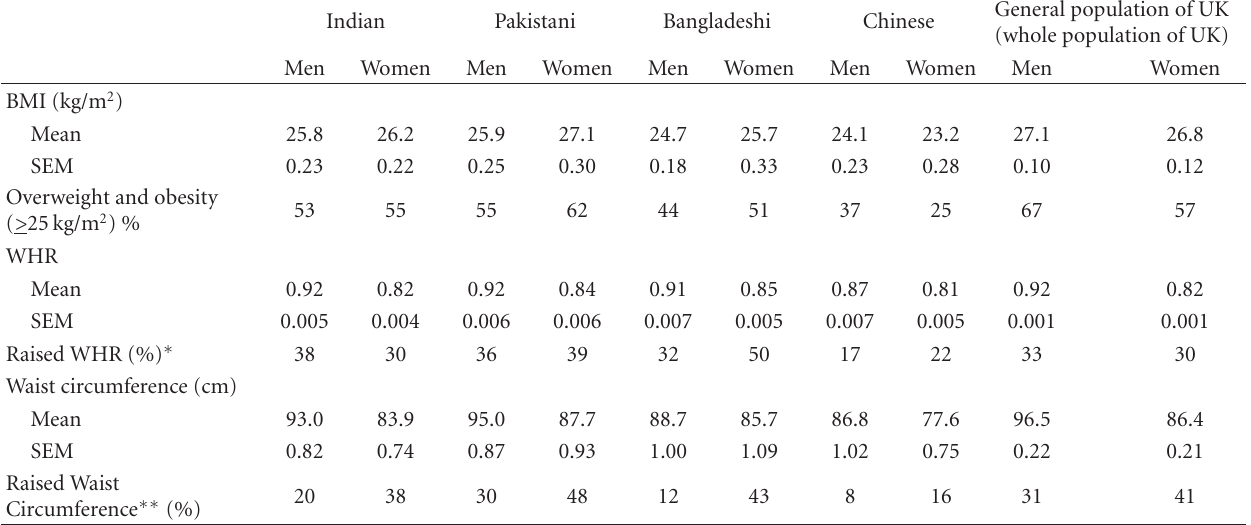
Table 3: Comparison of body mass index, waist hip ratio and waist circumference in Asian populations and the general population aged 16 years and above in the UK (Health Survey England 2004